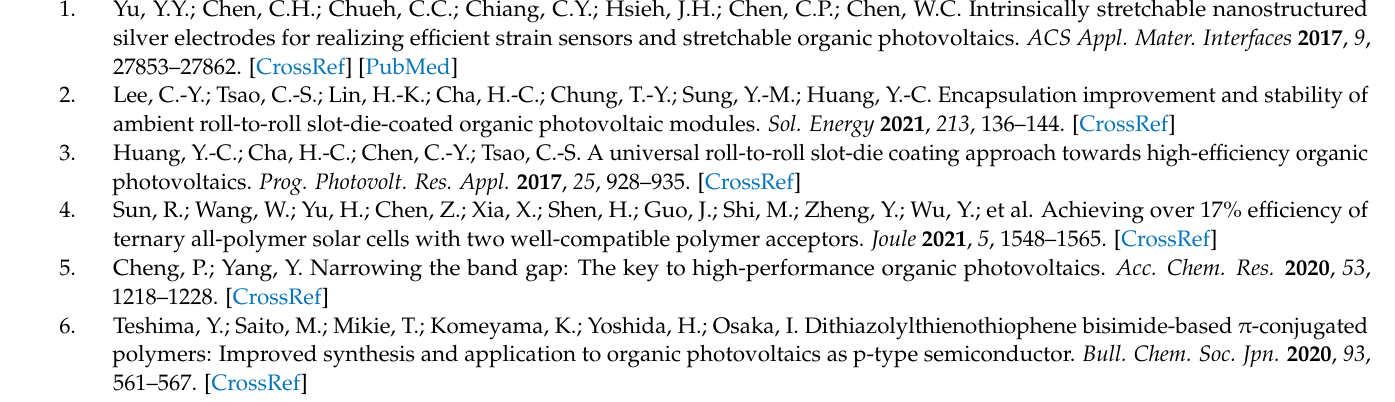
Figure S4: UV–Vis absorption spectra of the BPTI derivatives (a) as solutions in CHCl 3 and (b) in the form of glass/BPTI substrates; Figure S5: Tapping-mode AFM images of the (a) ZnO, (b) Figure S6: TRPL spectra of blend films prepared with and without IFLs; Figure S7: Normalized TPC data for the control and BPTI-C 3 NH 3 I-modified devices; Table S1: Contact angles and surface energies of SA-treated IFLs; Table S2: Carrier lifetime parameters of the blend